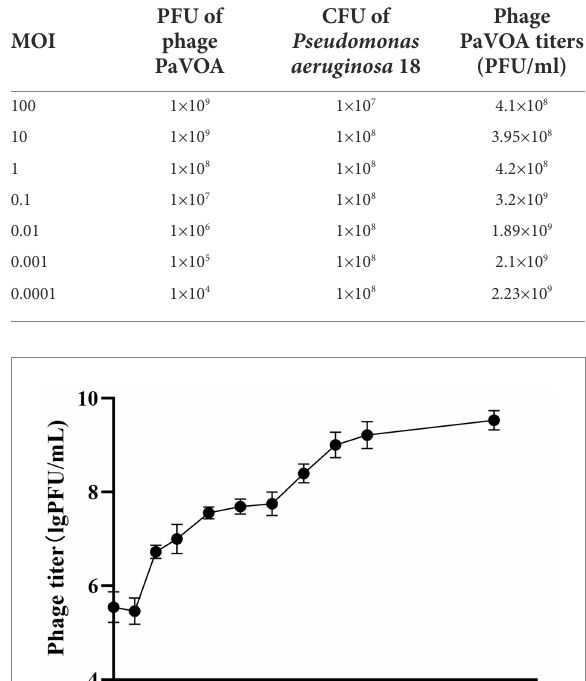
TABLE 1 Determining the optimal multiplicity of infection of phage PaVOA.